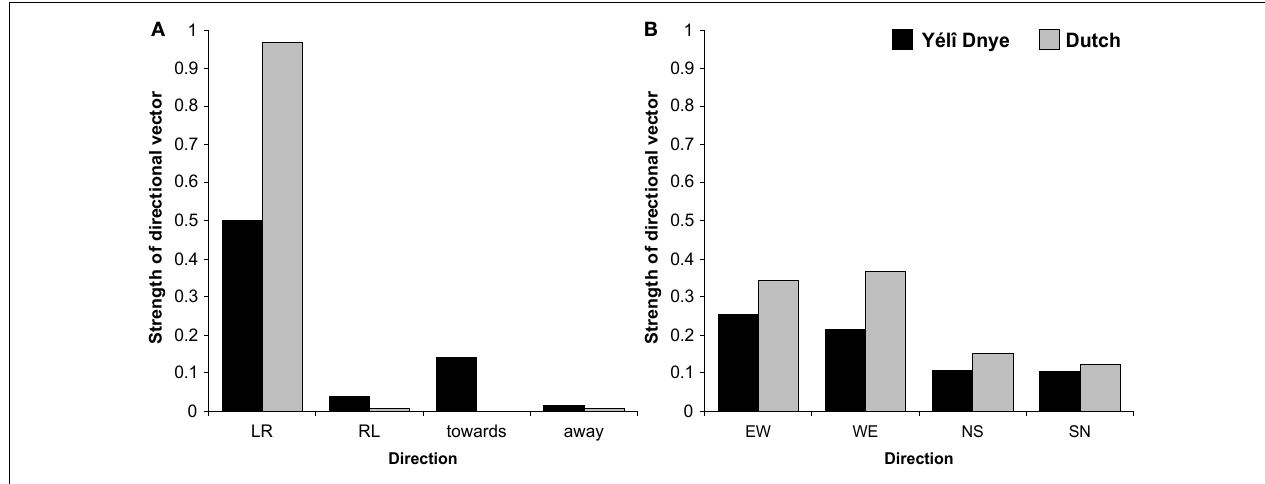
FIGURE 8 | Placement of verbal temporal sequences. (A) Shows the proportion of left-to-right (LR), right-to-left (RL), toward-the-body, or away-from-the-body responses. (B) Shows the proportion of responses across participants that used an east-to-west (EW), west-to-east (WE), north-to-south (NS), or south-to-north (SN)